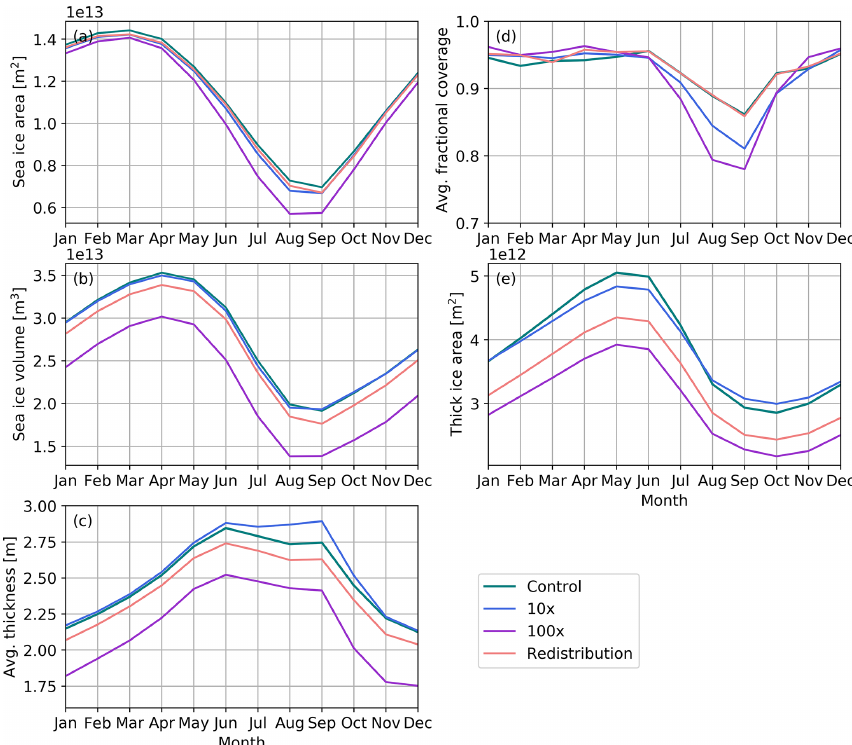
Figure 3. Seasonal cycle of Northern Hemisphere (a) sea ice area (m 2 ); (b) sea ice volume (m 3 ), (c) average sea ice thickness (m); (d) average fraction of sea-ice-covered area, calculated as ratio of sea ice area to sea ice extent; and (e) area with thick ice (greater than 2.5m) for all sensitivity runs with preindustrial forcing – control run (teal), 10 × lateral melt run (blue), 100 × lateral melt run (purple), and redistributed lateral melt (light red). Results shown are averages over the last 5 run years for the redistributed lateral melt run and the last 25 years for all others.